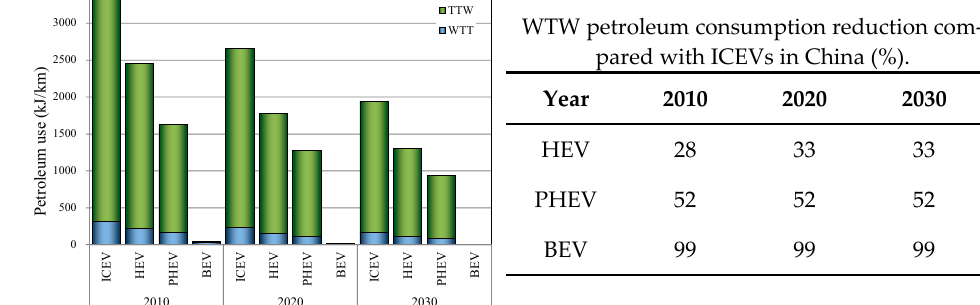
Figure 4. WTW petroleum consumption of ICEVs/HEVs/PHEVs/BEVs in China. WTW petroleum consumption reduction com- pared with ICEVs in Inner Mongolia (%).